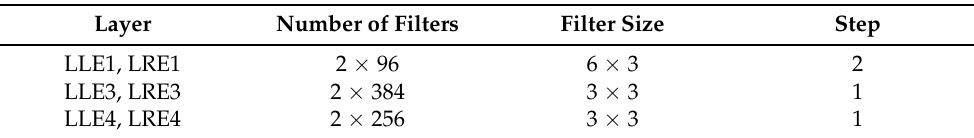
Table 2. Characteristics of convolutional layers for an experiment using both eyes images as neural network